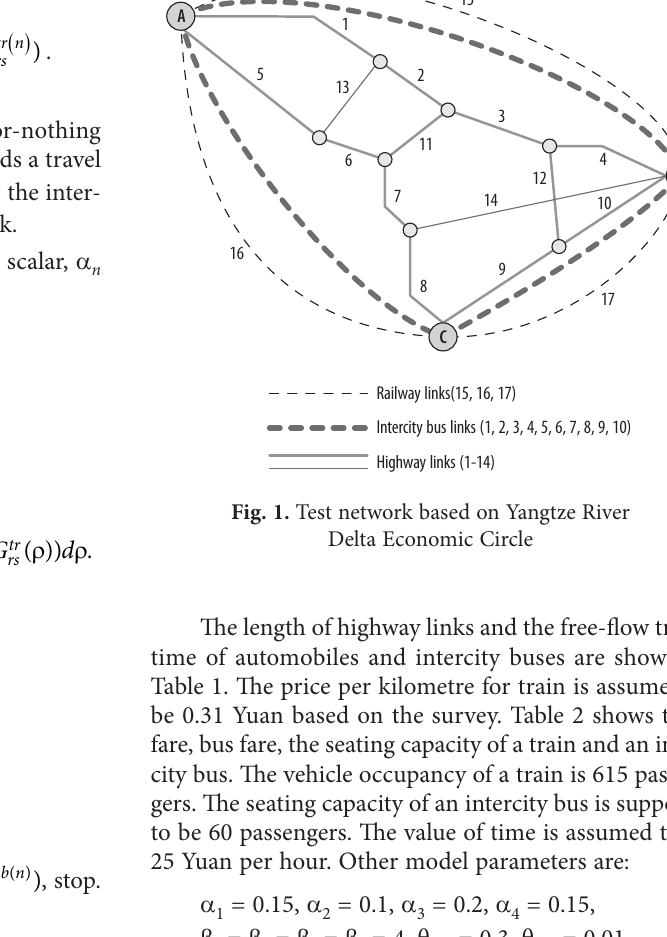
the railway links; red lines denote highways the capaci- ty of which is 3600 passenger car units (pcu) per hour and 1800 intercity buses per hour respectively; green lines represent highways the capacity of which makes 3200 pcu per hour. Intercity bus lines are supposed to be fi xed, as shown in Fig. 1. Th e bus line from A to B consists of link 1, 2, 3 and 4, the bus line from A to C consists of link 5, 6, 7 and 8 and the bus line from B to C consists of link 9 and 10.